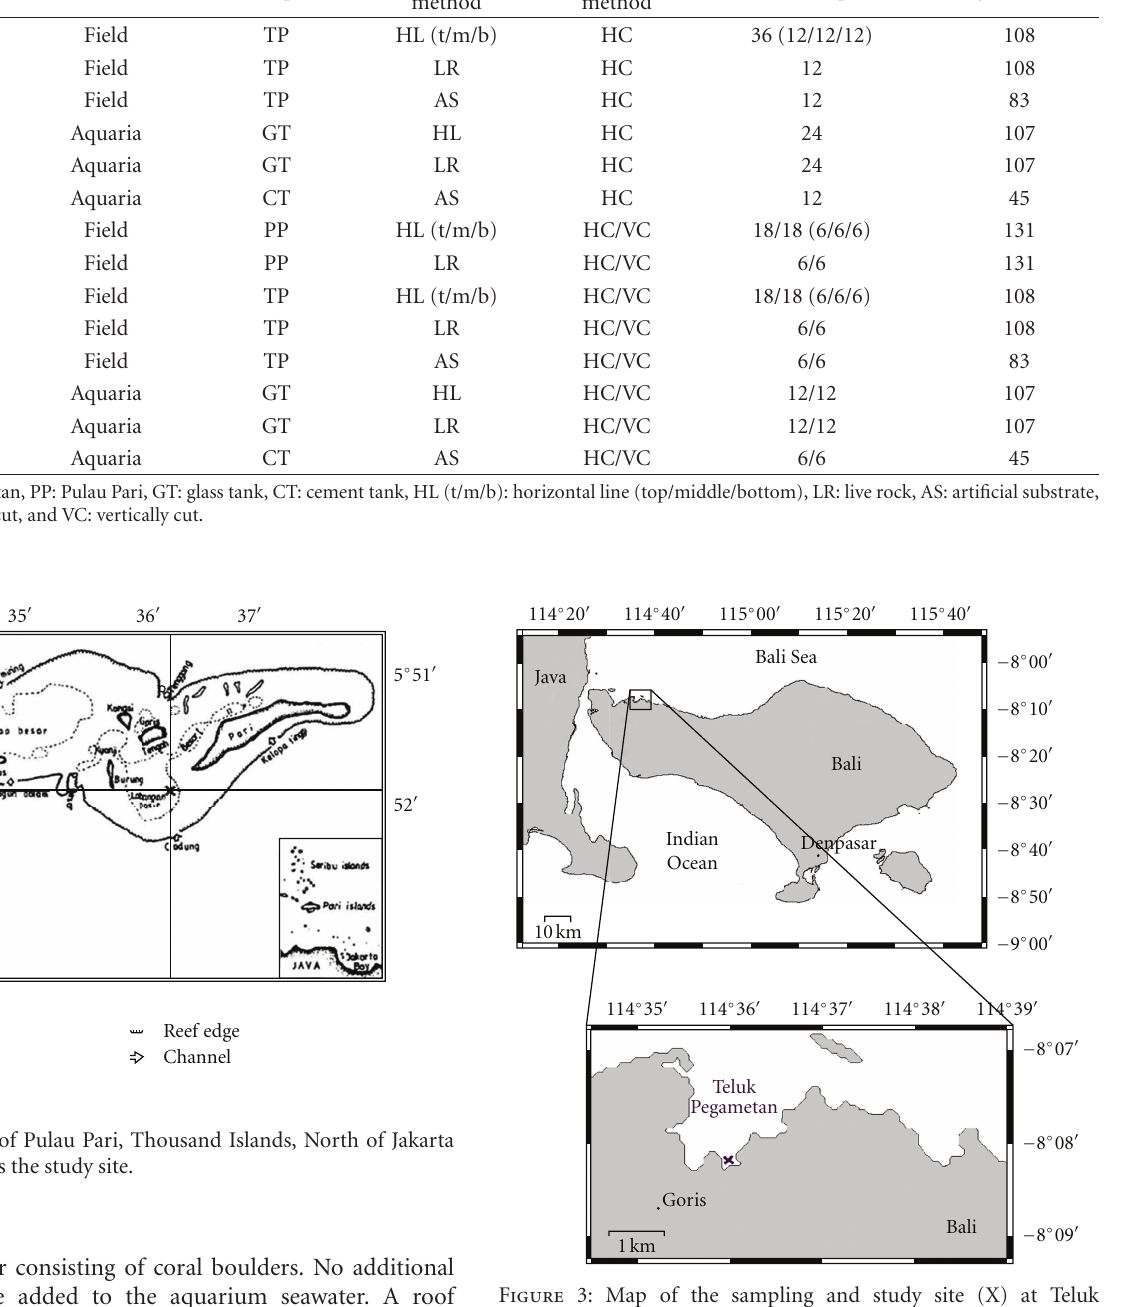
Stylissa massa. The fragmentation of S. massa was done